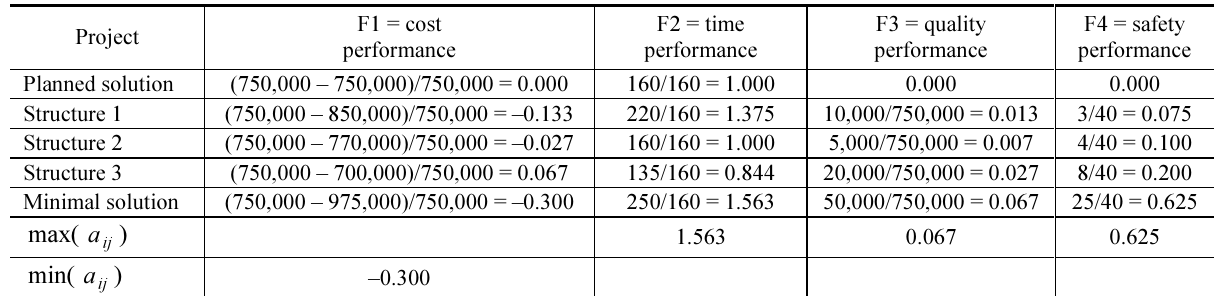
Table 4. Criteria